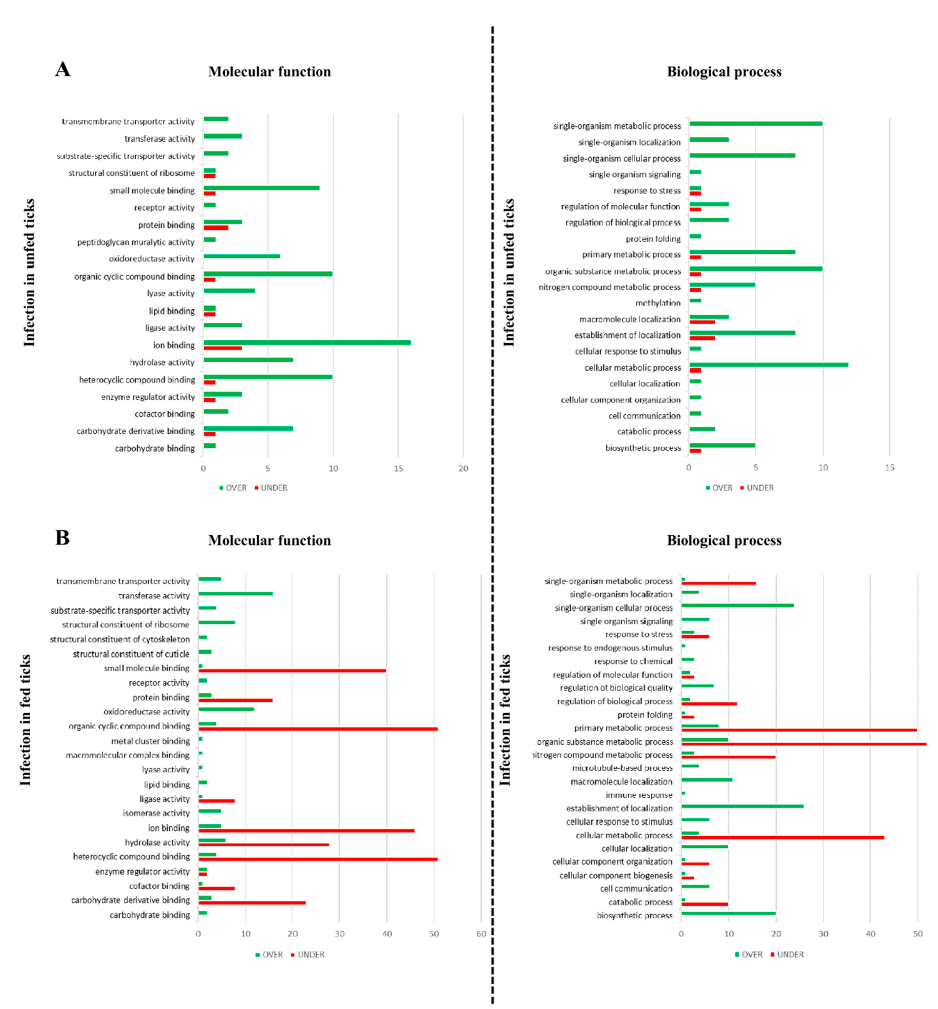
Figure 3. Gene ontology of the effect of B. ovis infection in unfed ( A ) and fed ( B ) R. bursa ticks. Functional terms at level 3 were assigned based on UniProt and associated databases. Green bars = over-represented proteins, red bars = under-represented proteins.